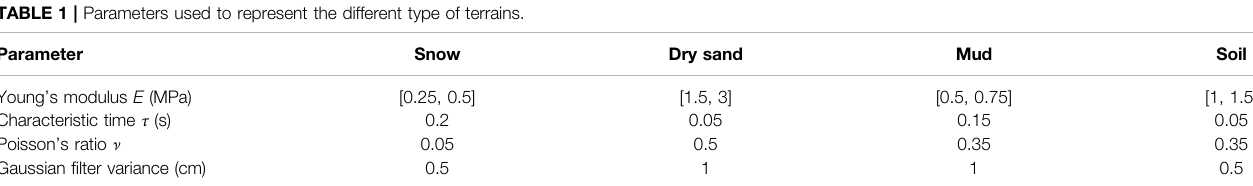
TABLE 1 | Parameters used to represent the different type of